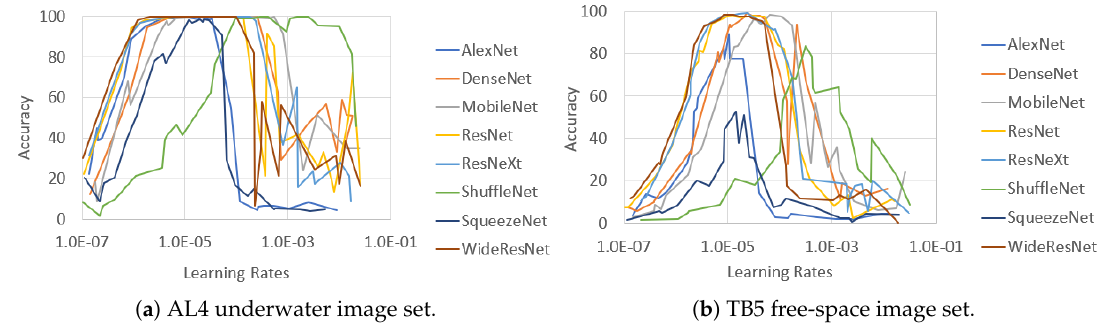
Figure 9. Hyperopt learning rate search using AL4 underwater and TB5 free-space image